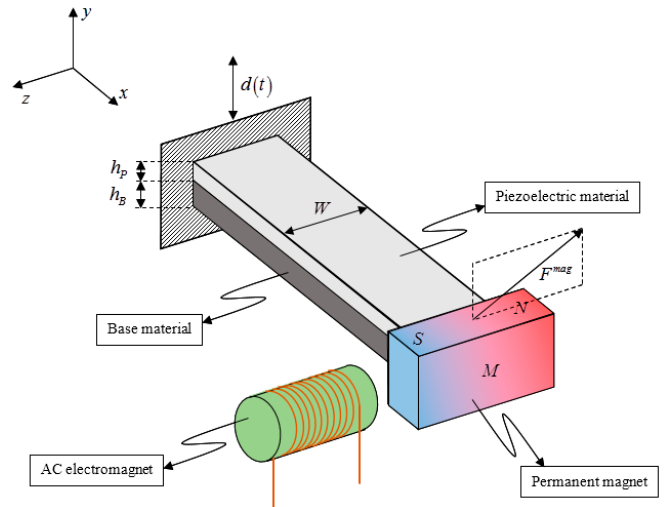
Figure 1. Schematic view of the micro-electro-mechanical systems (MEMS)-based piezoelectric unimorph harvester.